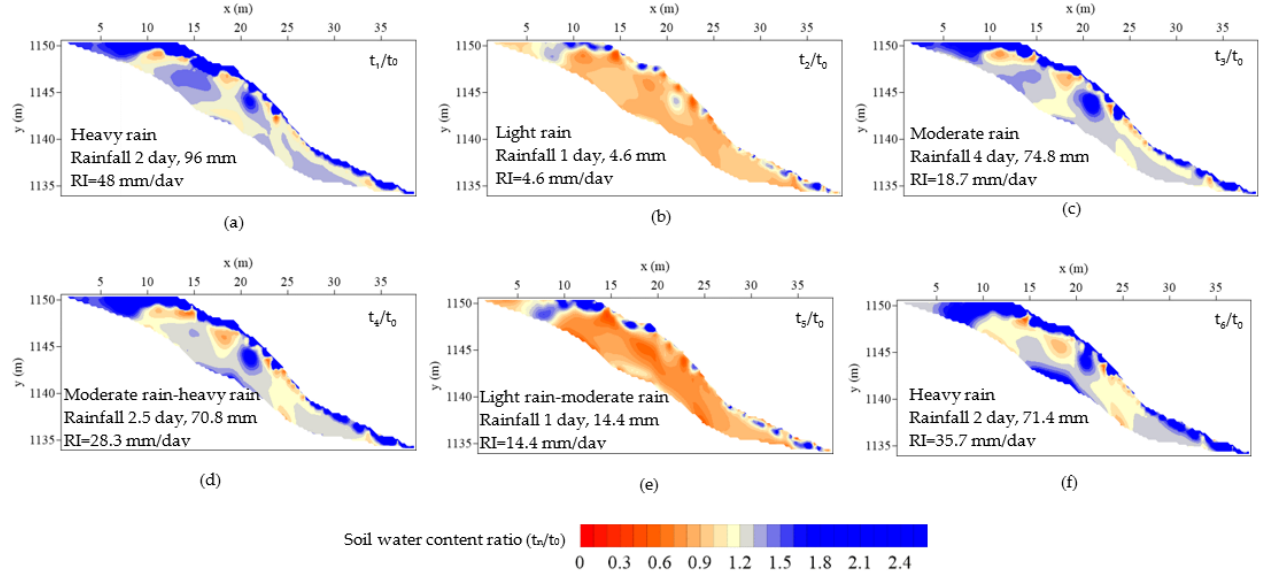
Figure 9. Soil water content ratio field plots calculated using the relationship between apparent re- sistivity and soil water content (x = Distance, y = Elevation). ( a – f ) is the distribution of slope soil water content ratio field under different rainfall conditions.